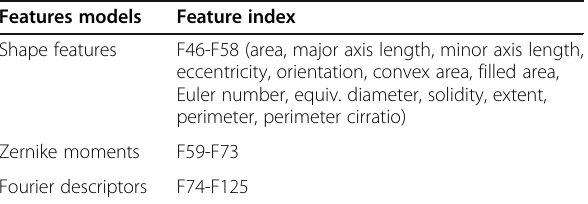
Table 3 Various shape and margin